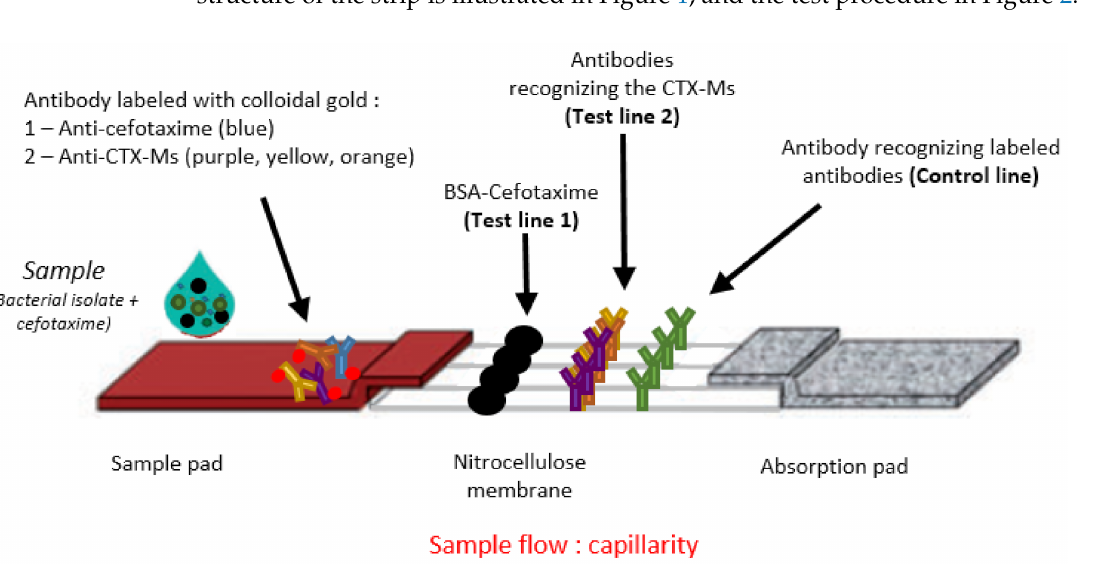
Figure 1. Structure of the strips. The strip consists of the sample pad with dried gold-labelled mAbs (anti-cefotaxime + anti-CTX-Ms); the nitrocellulose membrane with a Test Line 1 consisting of intact CTX coupled with BSA; a Test Line 2 consisting of mAbs recognizing CTX-Ms; a control line consisting of mAbs recognizing the colloidal gold-labelled mAbs; and the absorption pad which allows the sample to migrate along the